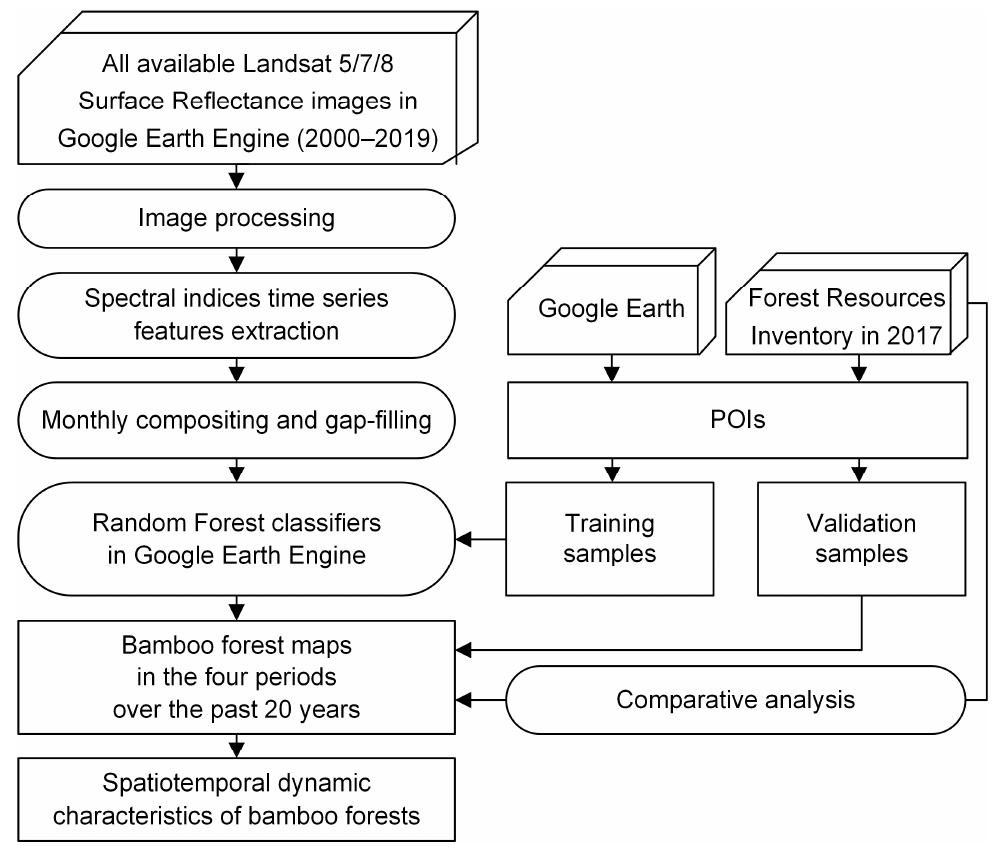
Figure 2. Workflow of the analysis of bamboo forest dynamics over the past 20 years using Landsat time series stacks and Google Earth Engine.